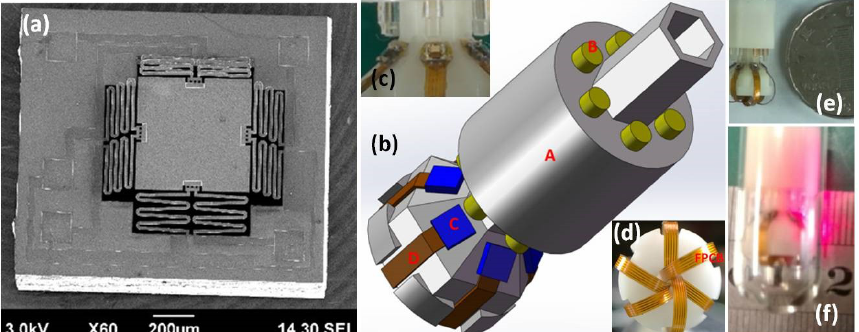
Figure 3. Electrothermal MEMS scanner-based OCT catheter. ( a ) A SEM image of the MEMS scanner. ( b ) The schematic 3D drawing of the probe design. A: 3D-printed probe head; B: C-lens collimators; C: the MEMS chips; D: FPCB. ( c ) A zoom-in picture showing the C-lens collimators and MEMS chips.